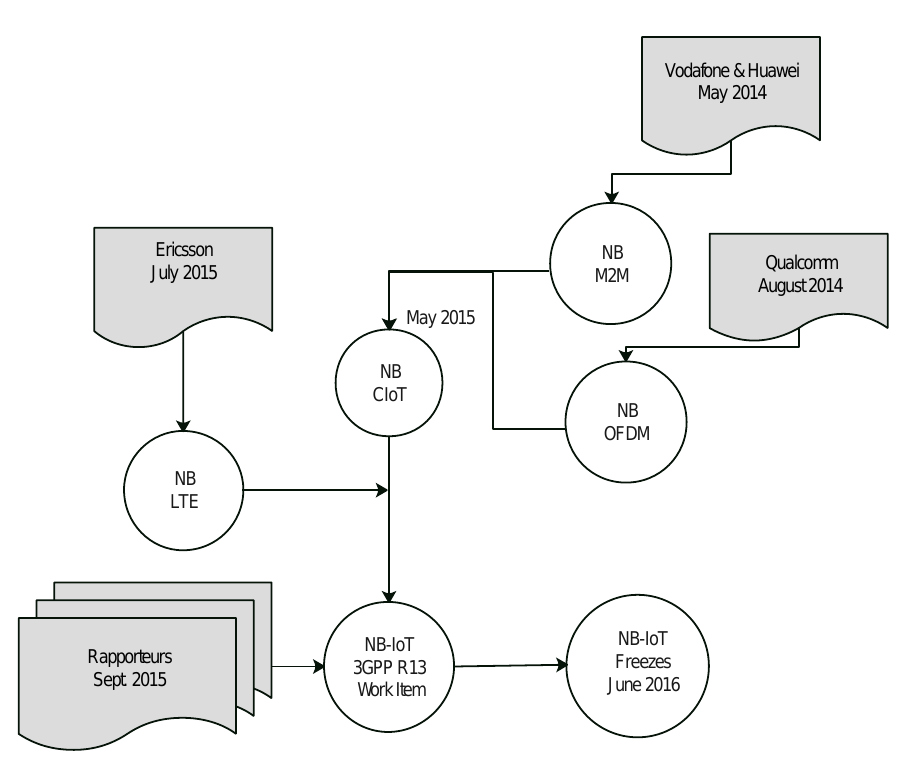
Figure 9. Participating companies in NB-IoT